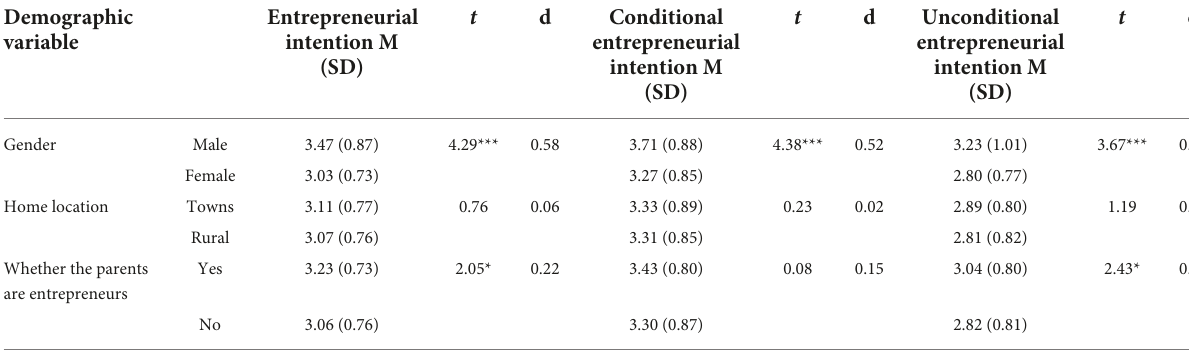
TABLE 2 Statistical of differences in demographic variables among college students’ entrepreneurial intention and its dimensions. Demographic variable